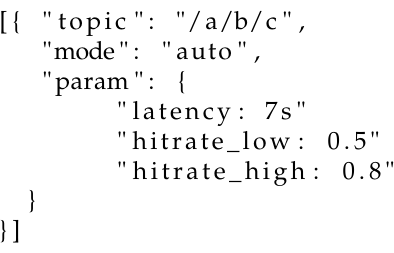
Figure 9. Activation of the QoS controller in autonomous